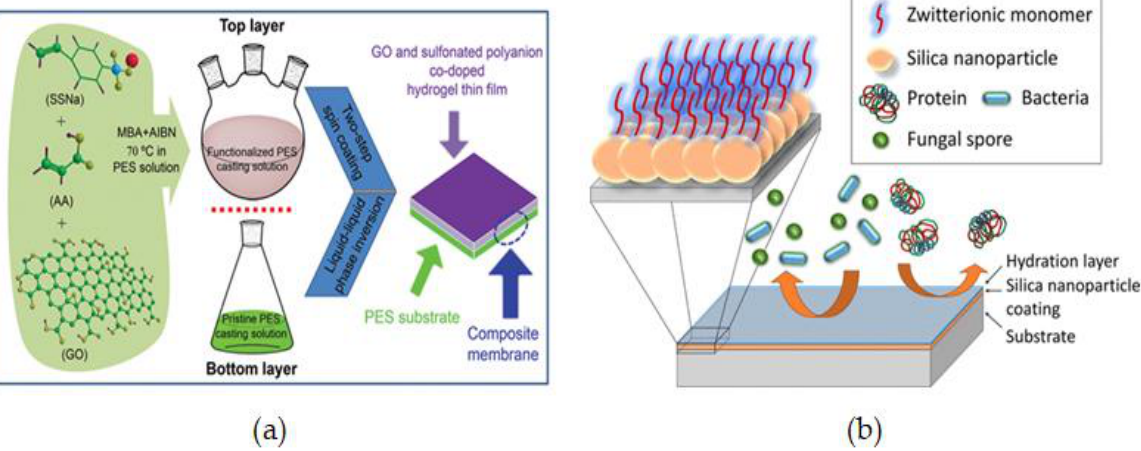
Figure 3. ( a ) Synthetic procedure of dual layer modified PES/GO-SPHF [101], ( b ) Surface modifica- tion of pre-deposited SiNPs functionalized with SB [102].